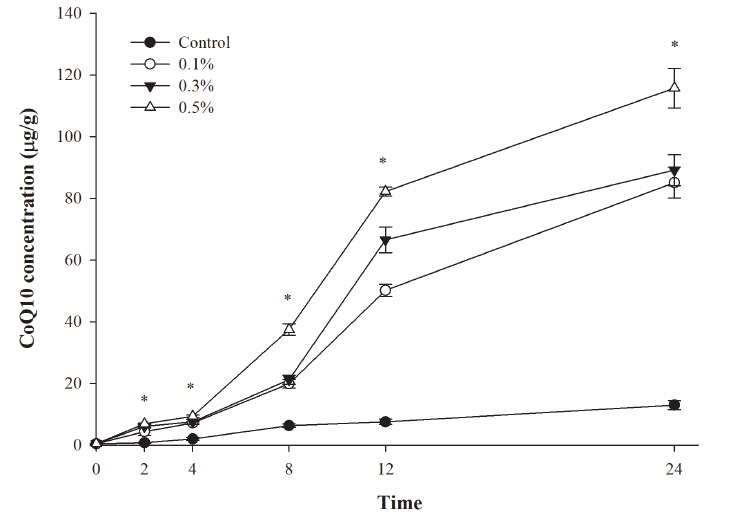
Figure 1. Effect of Rhodobacter sphaeroides KCTC 1434 supplementation in total mixed ration (TMR) on CoQ10 concentration in vitro. Control = TMR with no supplement; 0.1%, 0.3%, and 0.5% indicates TMR supplemented with 0.1%, 0.3%, and 0.5% R. sphaeroides). * Values differ significantly between treatments (p<0.05).